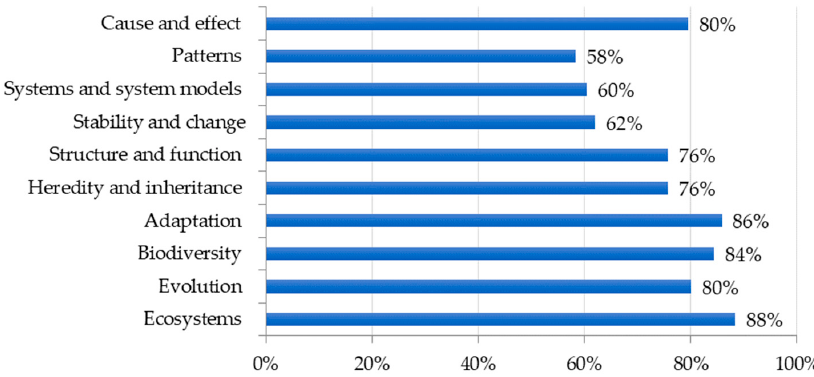
Figure 4. Life science concepts and core ideas supported by insect incorporation.